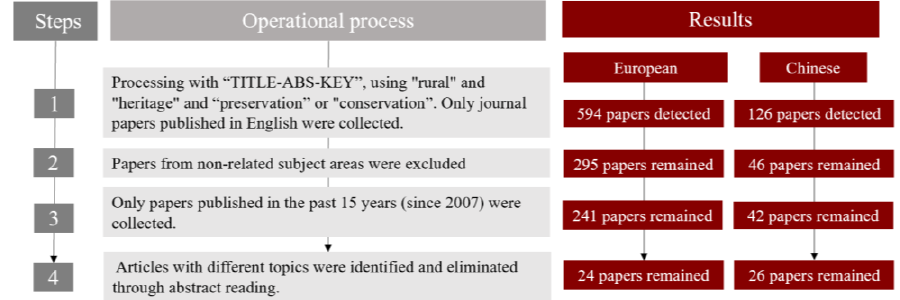
Figure 1. Flowchart of operational process for paper selection. Authors’s elaboration.